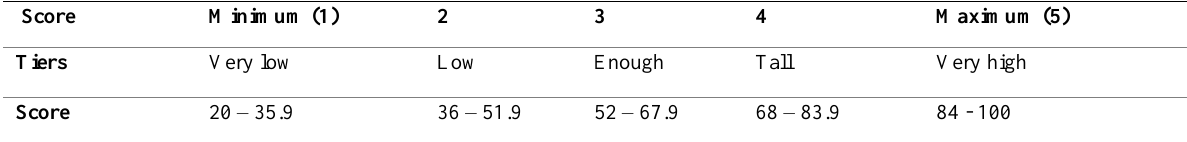
Table 3: Distribution of Answer